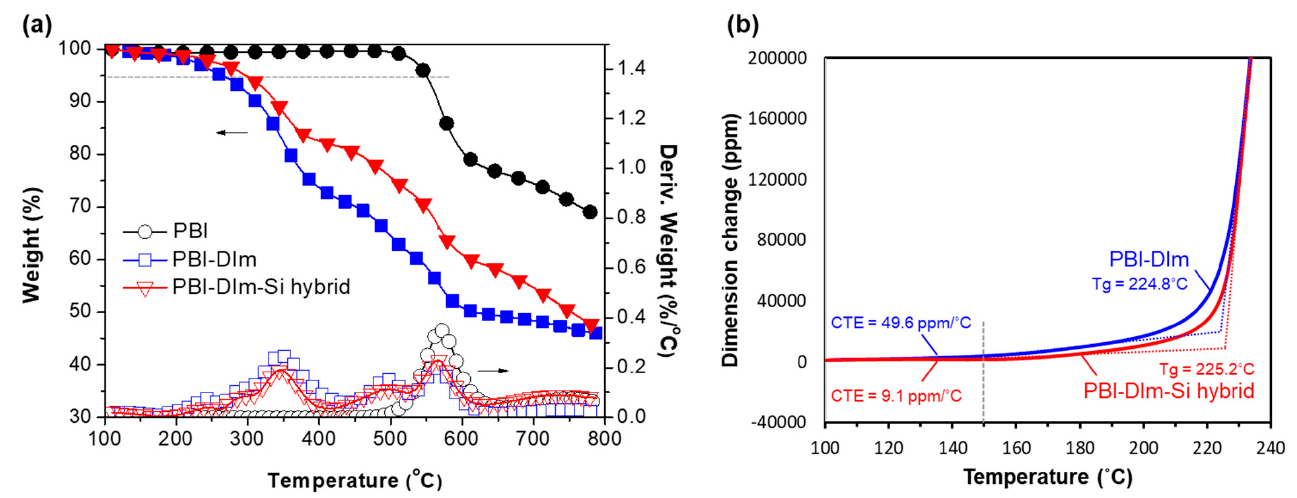
Figure 3. ( a ) Thermograms of PBI, PBI-Dim, and PBI-DIm-Si hybrid membranes in a temperature range from 100 ◦ C to 800 ◦ C under a nitrogen atmosphere. ( b ) Dimension changes of the PBI-DIm and PBI-DIm-Si hybrid membranes as a function of temperature.